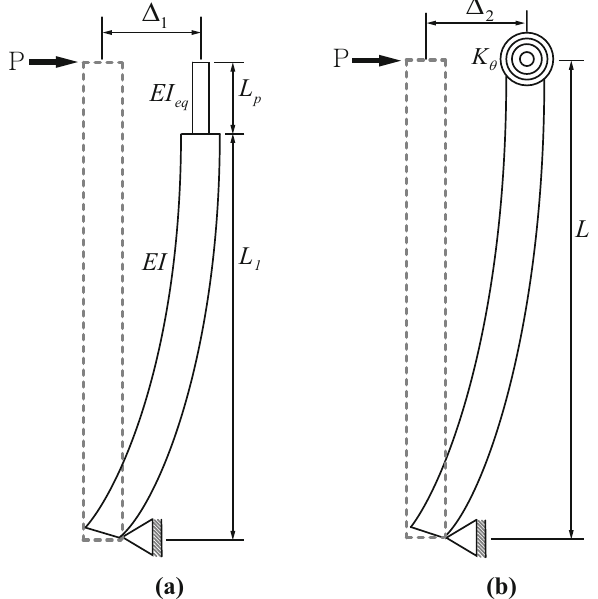
Fig. 5 Half-span RC column considering the equivalent bending stiffness EI eq . a Simplified model with EI eq and b equivalent model with K h